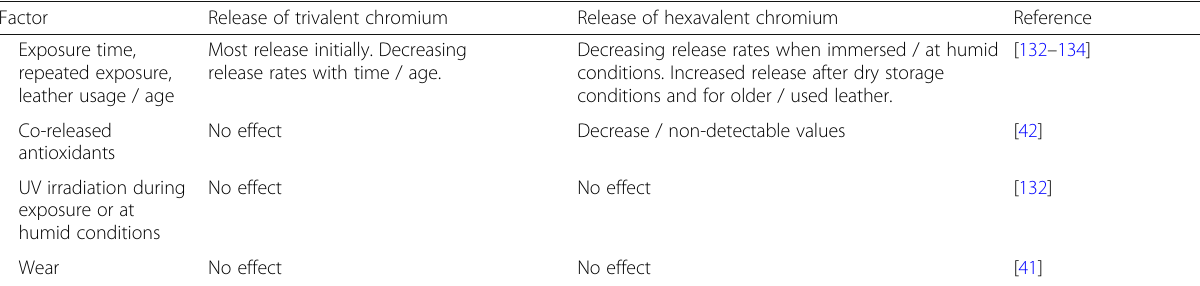
Table 2 Most important tanning, leather, and exposure factors/conditions for the release of trivalent and hexavalent chromium from chromium-tanned leather